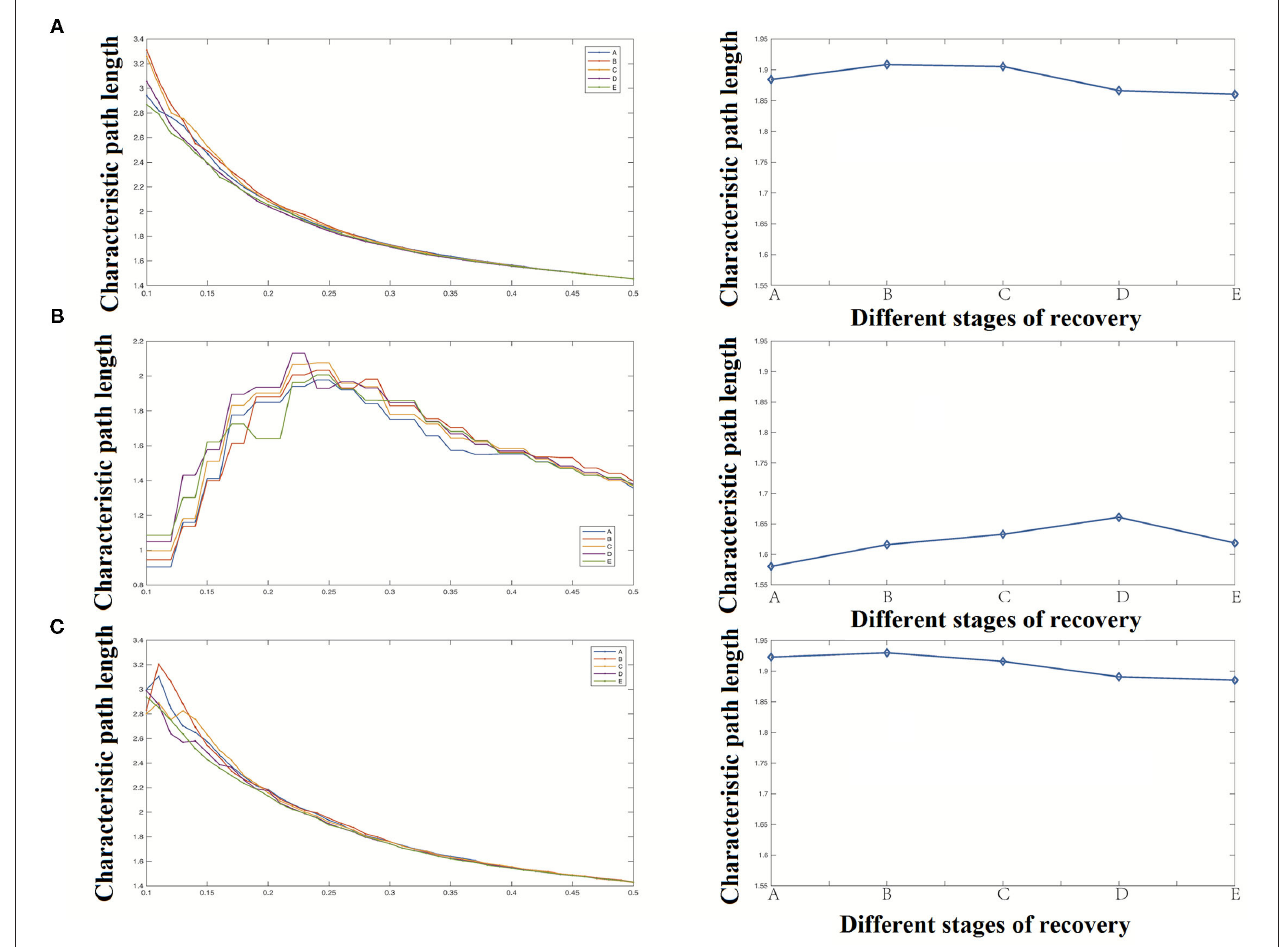
FIGURE 7 | Characteristic path length analysis results [ (A) Characteristic path length of the whole network, (B) Characteristic path length of the cortical region, (C) Characteristic path length of the deep region].